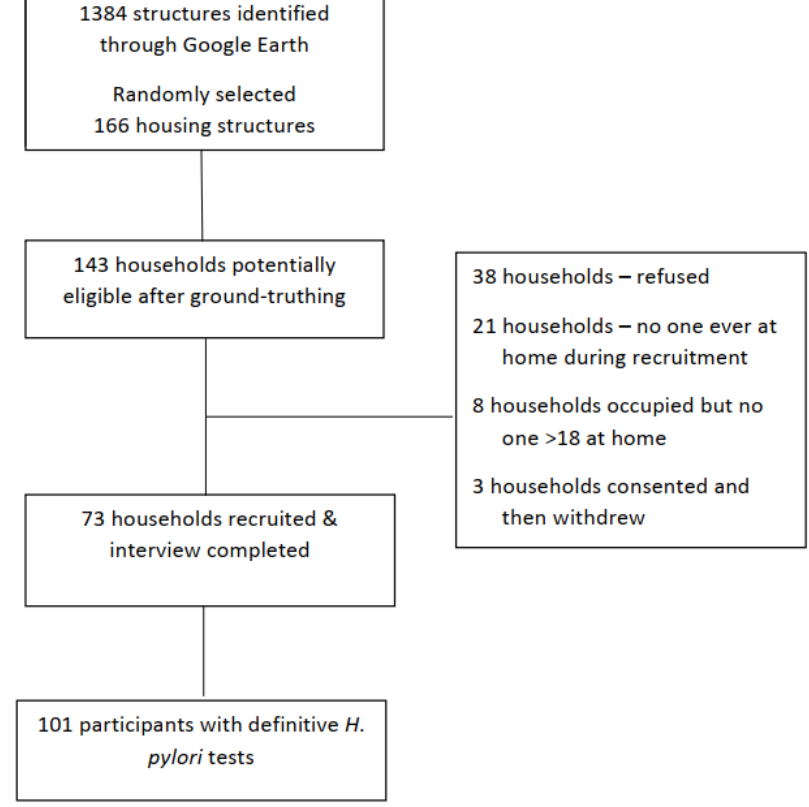
Figure 1. Flow of household recruitment to the Navajo Healthy Stomach Project.